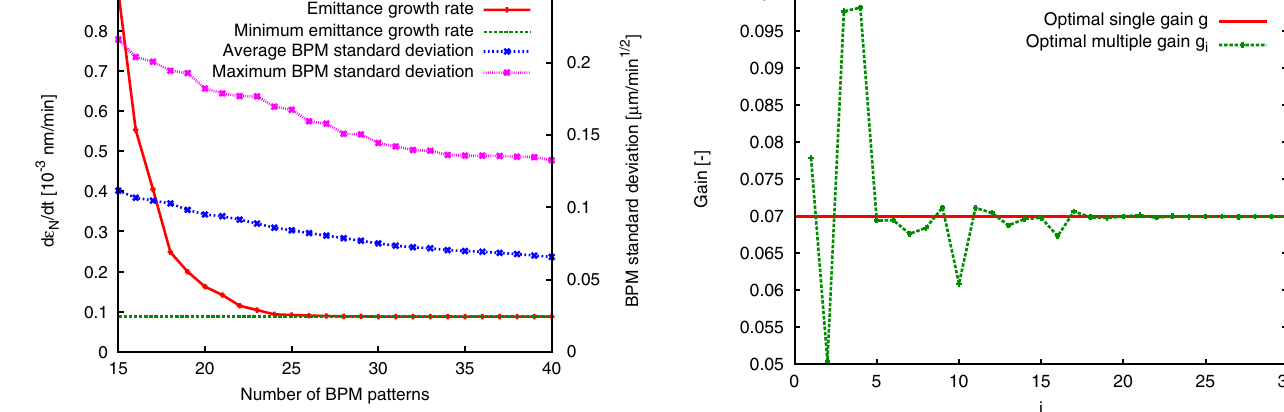
FIG. 24. (Color) Optimal values of a single gain parameter and of multiple gain parameters (for each BPM pattern i ). The optimal single gain g (cid:6) 0 : 07 was used as a starting point for during the optimization proce- the multiple gain parameters g i dure.